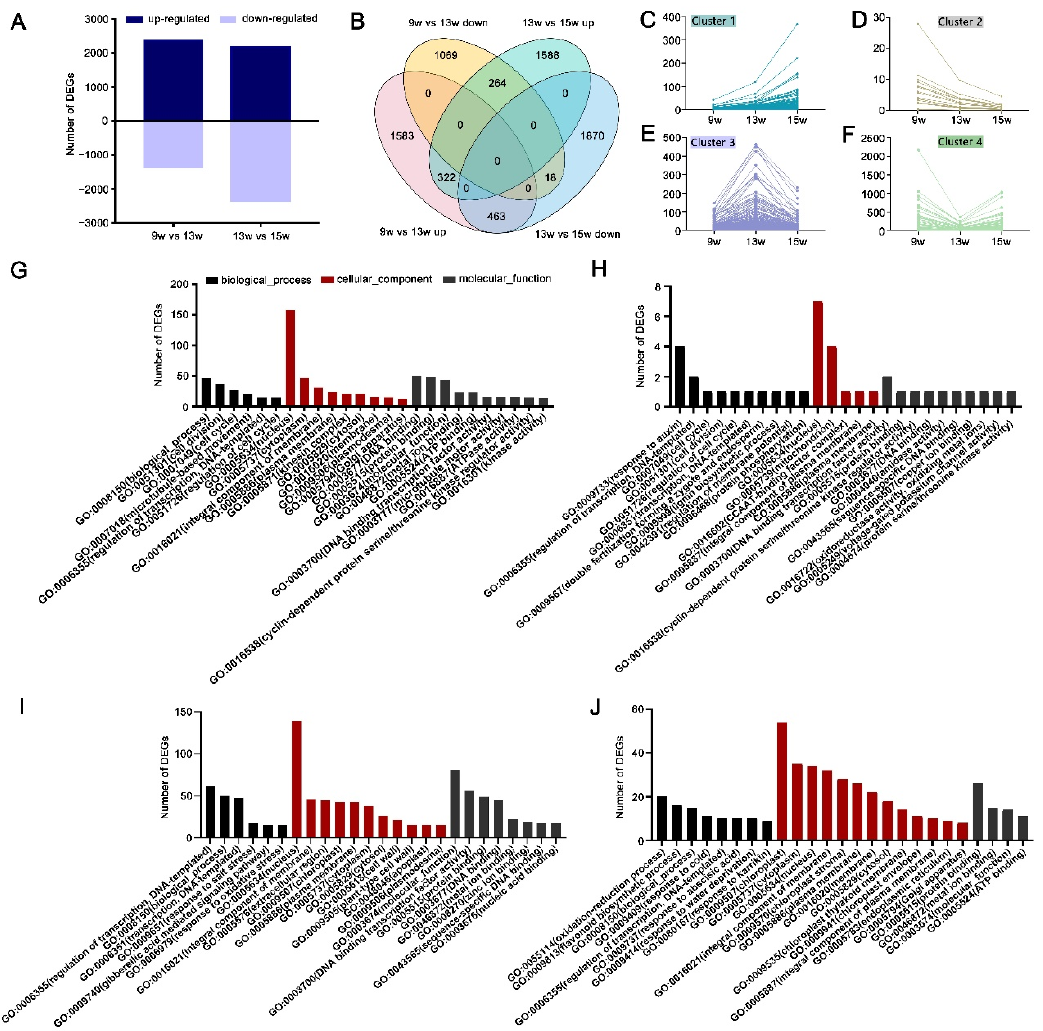
Figure 2. Differential gene expression and GO enrichment analysis during flowering in strawberry. ( A ) Number of up-regulated and down-regulated DEGs of 13 w and 15 w. ( B ) Venn diagram of DEGs in the 13 w and 15 w RNA-seq libraries. ( C – F ) Expression of the DEGs at 9 w, 13 w, and 15 w in clusters 1 − 4, based on the overlaps in the Venn diagram in panel B. ( G – J ) GO enrichment analysis of DEGs in cluster 1 ( G ), cluster 2 ( H ), cluster 3 ( I ), and cluster 4 ( J ).